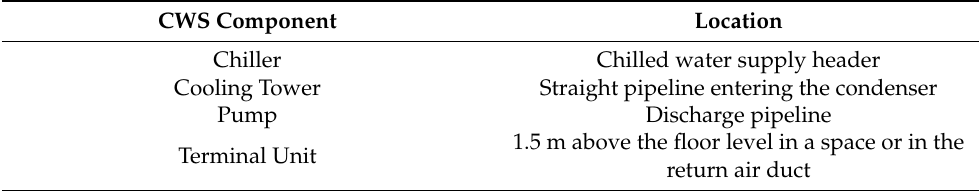
Table 3. Best Location for Reading